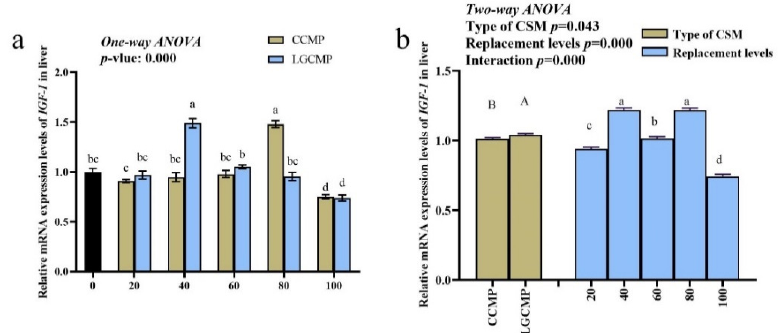
Figure 3. Expression of hepatic IGF-1 in hybrid grouper juveniles fed low-FM diets with different PBMP replacements by CCMP or LGCMP for 9 weeks. The gene expression of the PBMP group was set as 1. Figure ( a ) represented one-way ANOVA results and figure ( b ) represented Two-way ANOVA results. Subscript letters a,b,c,d showed significant differences among different PBMP replacement levels by CCMP or LGCMP and subscript letters A,B represented significant difference between CSM sources.